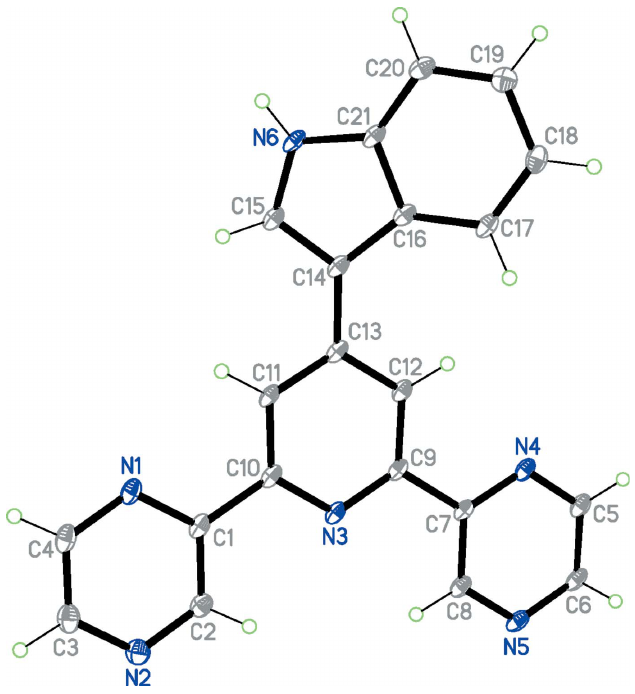
Figure 1 View of the title compound, shown with 50% probability displacement ellipsoids.